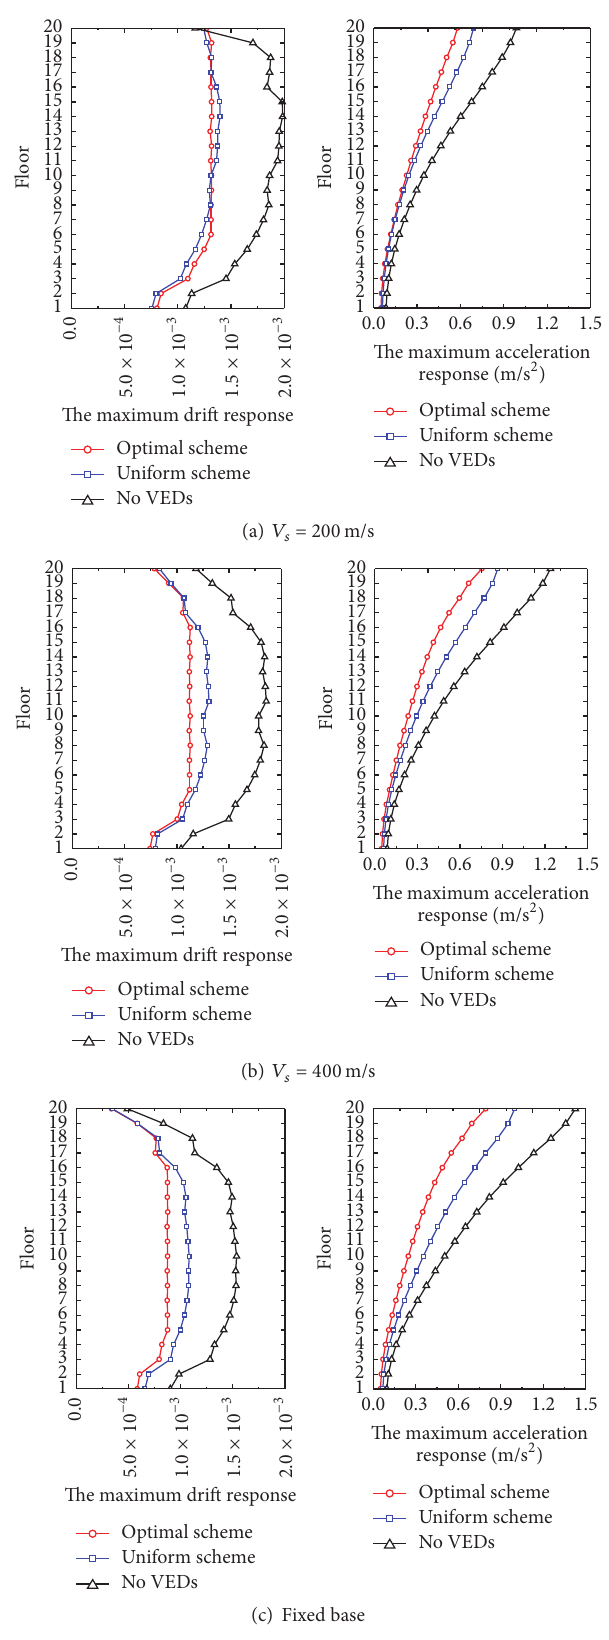
Figure 16: The comparison of structural responses for different distribution of VEDs (20-story